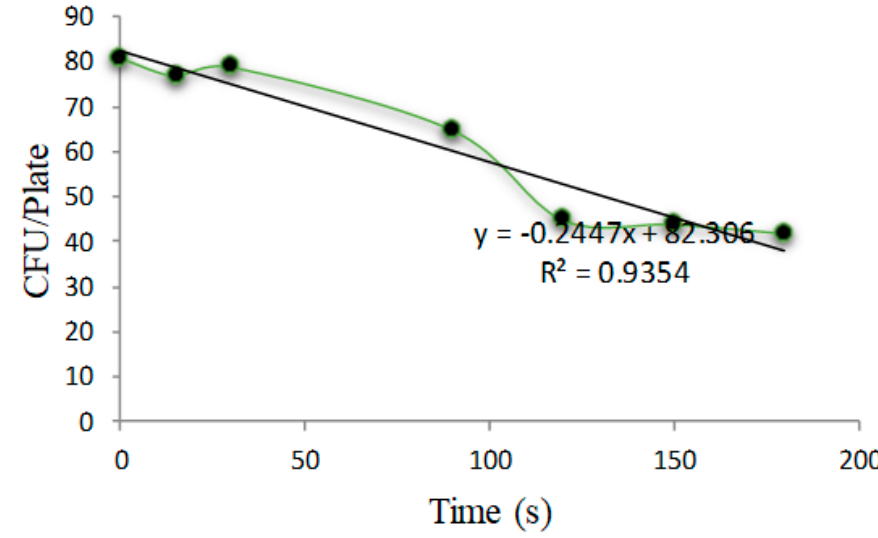
Figure 13. Change in CFU count of E. Coli with plasma treatment time.